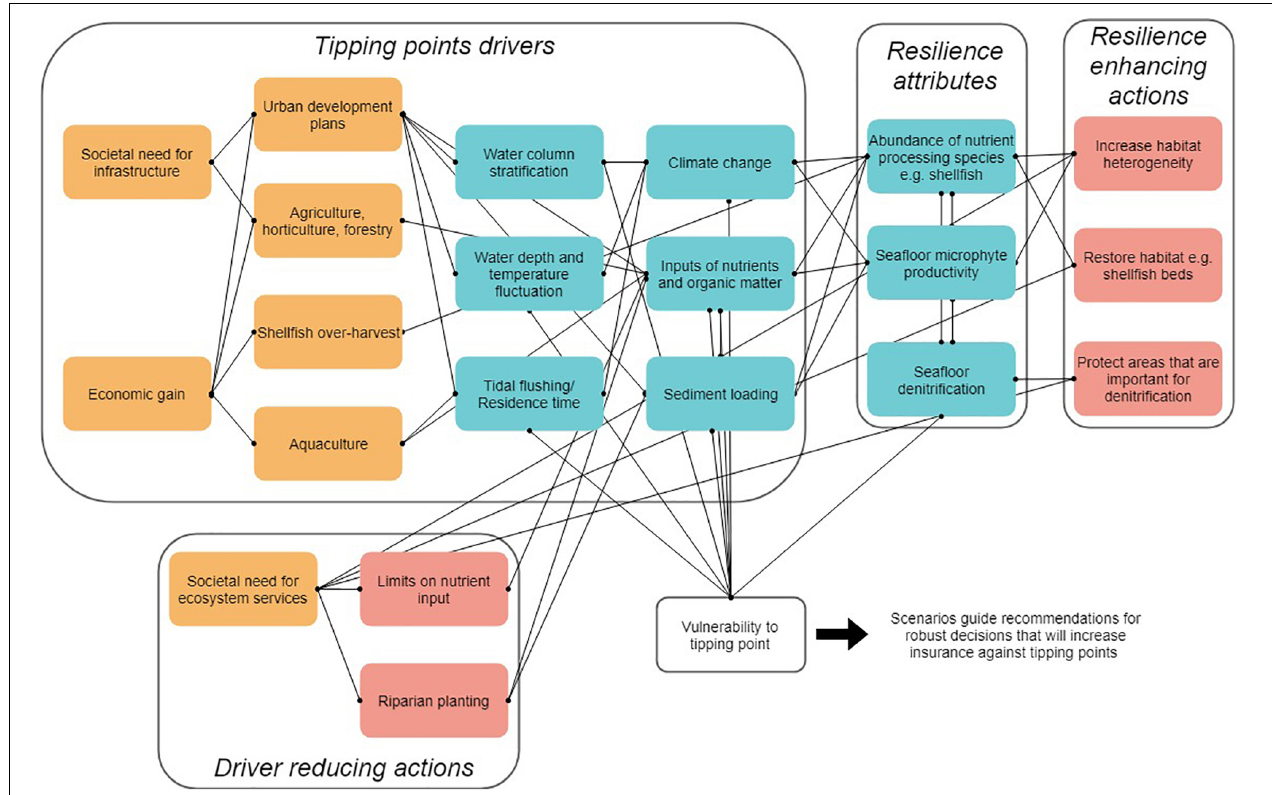
FIGURE 2 | Coastal eutrophication – a simplified model linking biophysical ecosystem properties (blue), social drivers (orange), and management actions (pink). The hypothetical model shows how the different spheres in Figure 1 can be linked together to determine vulnerability of a coastal area to tipping points induced by nutrient